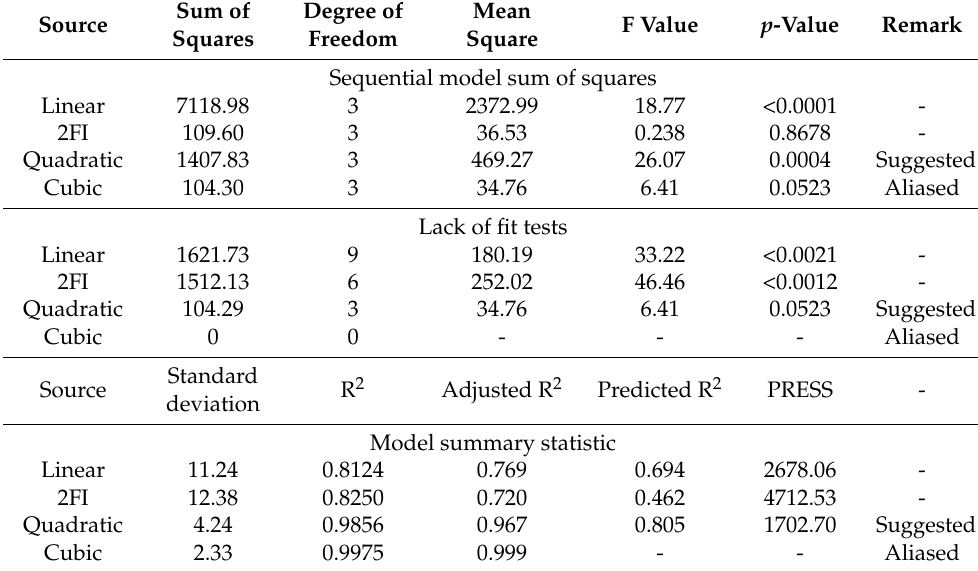
Table 4. Adequacy of the models tested.